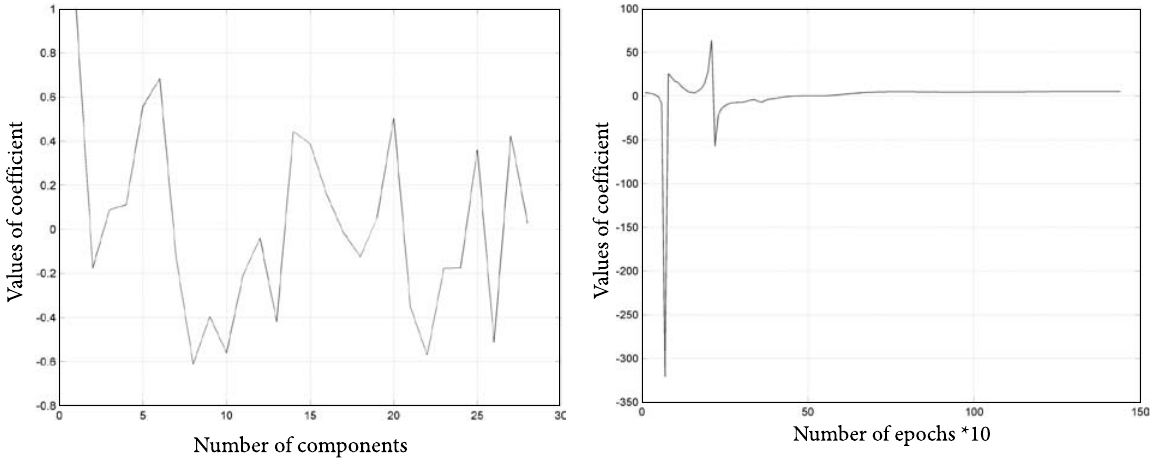
Fig. 3. Values of correlation coefficients of F ( t ) vectors Fig. 6. Values of covariation variation coefficient h of F ( t ) calculated each 100 epochs using data from Belsk2 and Hel30 vectors from data of Belsk2 and Hel30 observatories